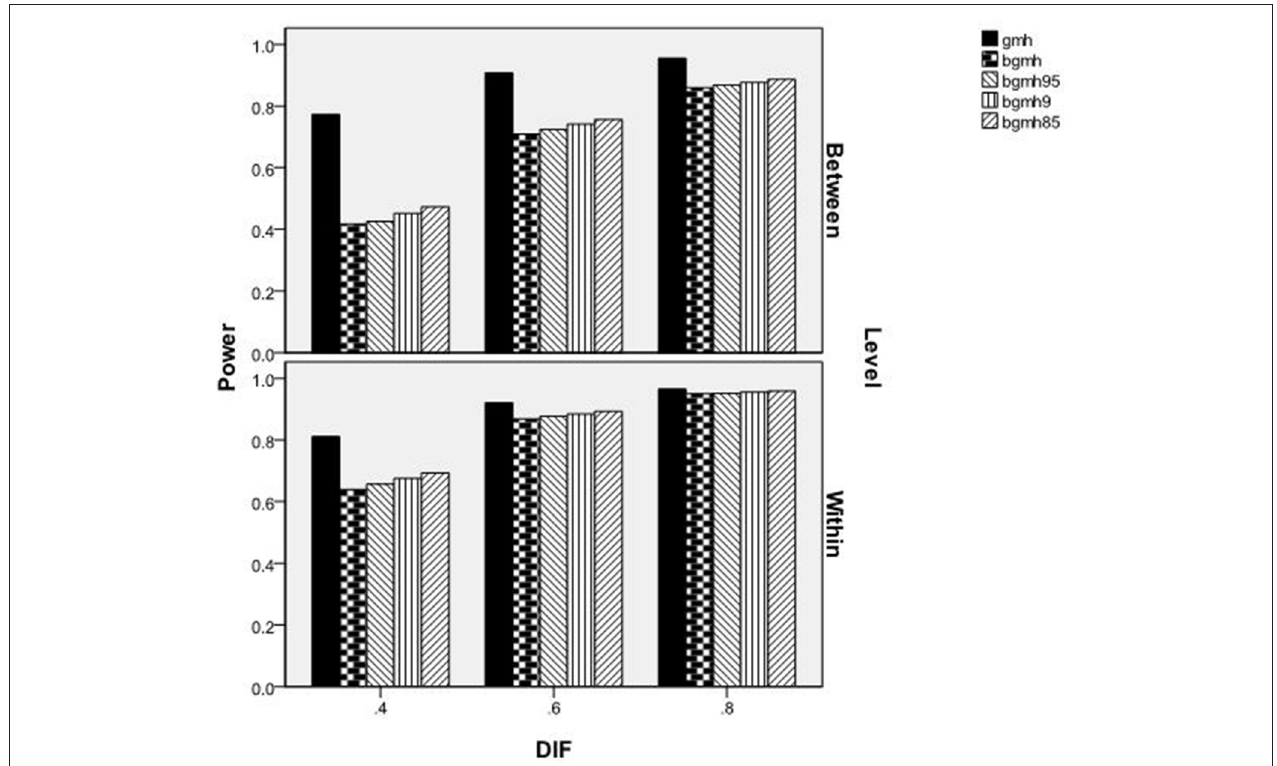
FIGURE 3 | Power by method, amount of DIF, and level of